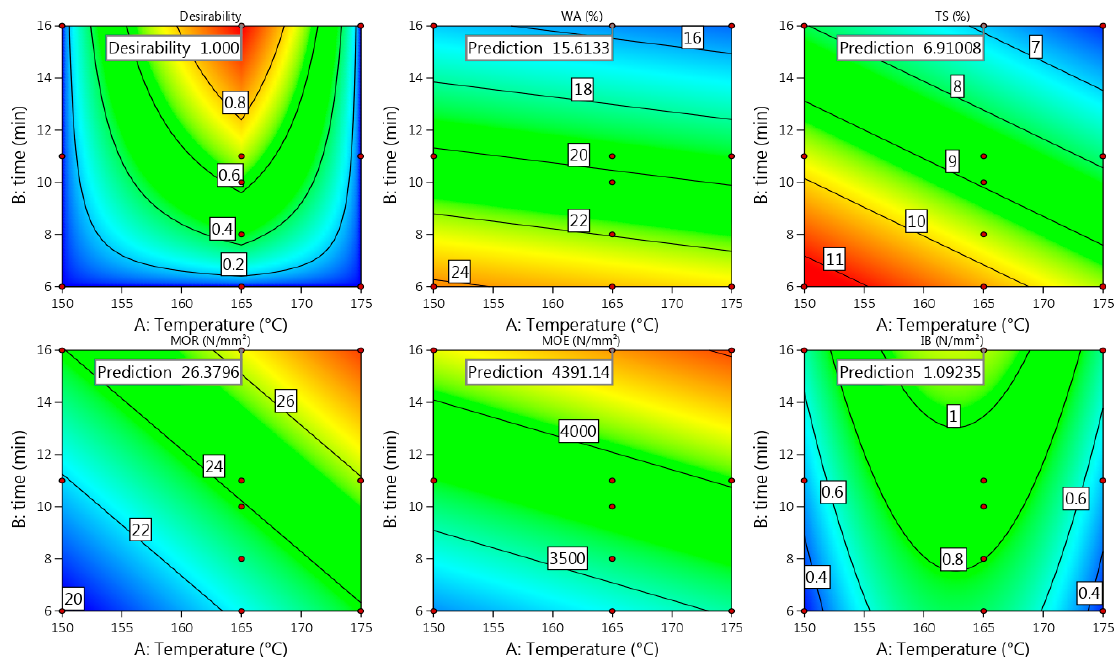
Figure 16. Contour plots with predicted values of Wh-1200 binder-less board properties at T = 165 °C and t = 16 min.